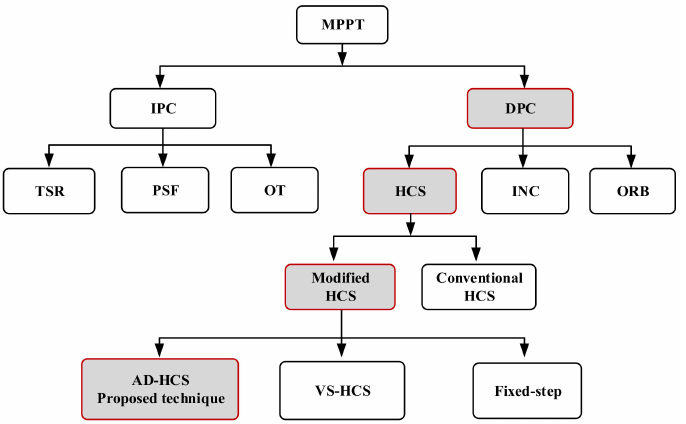
Figure 1. MPPT strategies